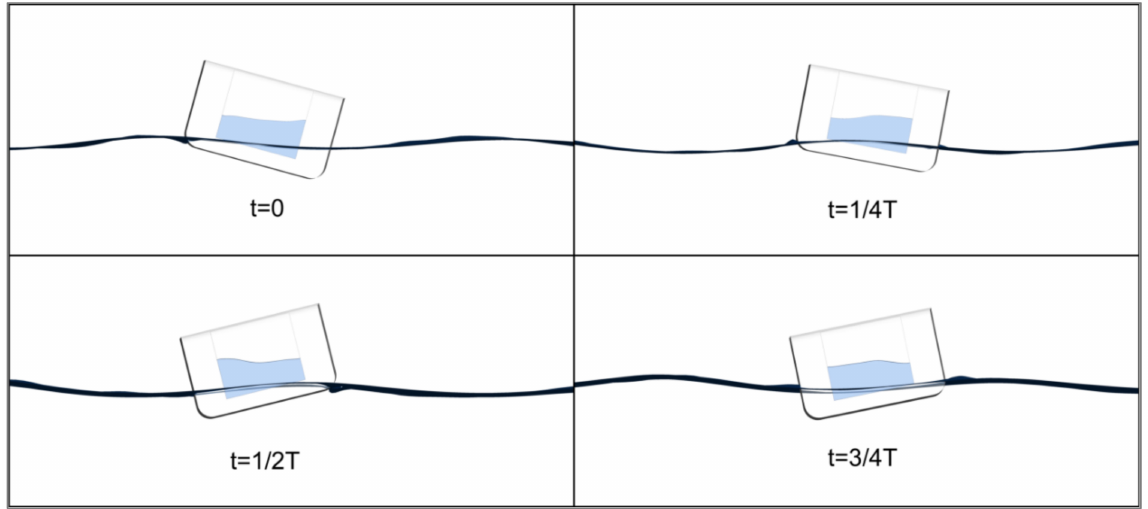
Figure 21. For the ship in beam waves at λ /L = 0.787 with the height of the liquid in the tank at 0.2 m, wave-induced ship positions and sloshing-induced surface elevations inside the tank at time steps of t = 0, t = 1/4 × T, t = 1/2 × T and t = 3/4 ×